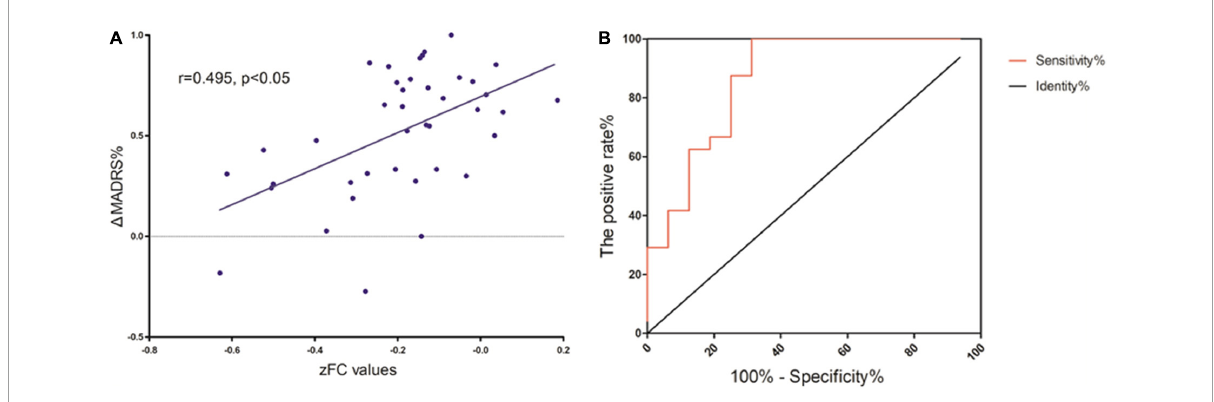
FIGURE4 (A) Correlation between zFC values and L’lMADRS% in MOD patients. (B) ROC curve showing an area under the curve (AUC) of 0.8672 ( p < 0.001) for the zFC values, with a sensitivity of 100%, and specificity of